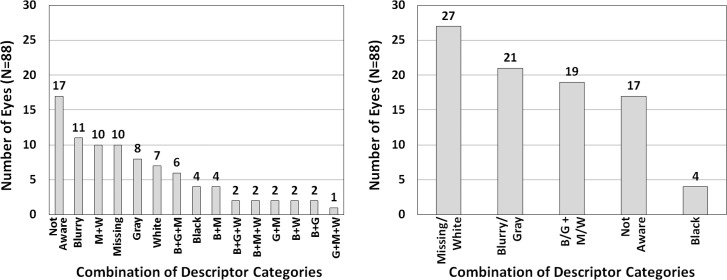
Number of eyes for each combination of descriptor categories.The number above the bar graphs represents the number of eyes in that combination (a total of 88 eyes). (Left) For 6 descriptor category classification in Table 1, and (Right) for 4 descriptor category classification in Table 1. A ‘+’ mark represents a combination of descriptor categories. B = Blurry, and G = Gray, M = Missing, W = White.